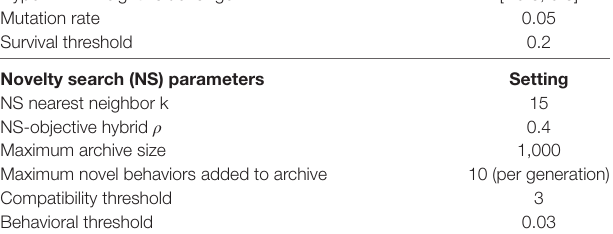
TaBle 2 | Neuro-evolution (NE) and novelty search (NS) parameters and settings. neuro-evolution (ne) parameters setting